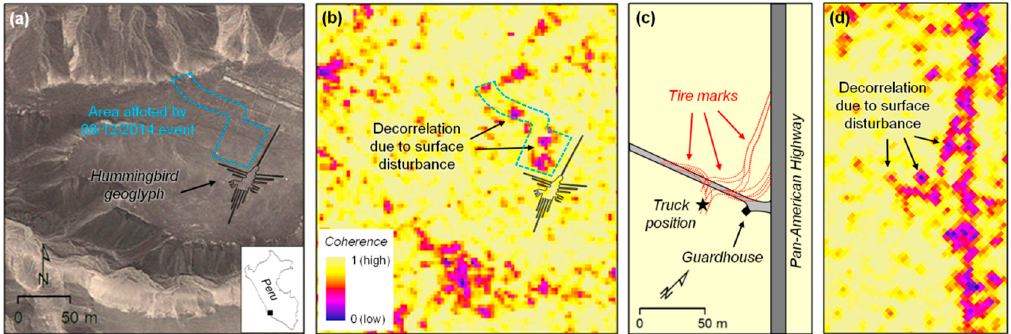
Figure 8. ( a ) Area affected by the surface disturbance event occurred on 08/12/2014 at the Hummingbird geoglyph in Nasca, Peru (Google Earth image © 2018 DigitalGlobe) and ( b ) COSMO-SkyMed StripMap Himage (~3 m ground resolution) InSAR coherence from cross-event pair 10/07/2014–12/04/2015 with 14 m perpendicular baseline; ( c ) sketch of the “plowing” event occurred on 27/01/2018 when a truck drove off the Pan-American Highway, and ( d ) COSMO-SkyMed StripMap Himage InSAR coherence from cross-event pair 13/12/2017–30/01/2018 with 19 m perpendicular baseline. Modified from Reference [52]. COSMO-SkyMed® Products ©ASI—Italian Space Agency—2014–2018. All Rights Reserved.